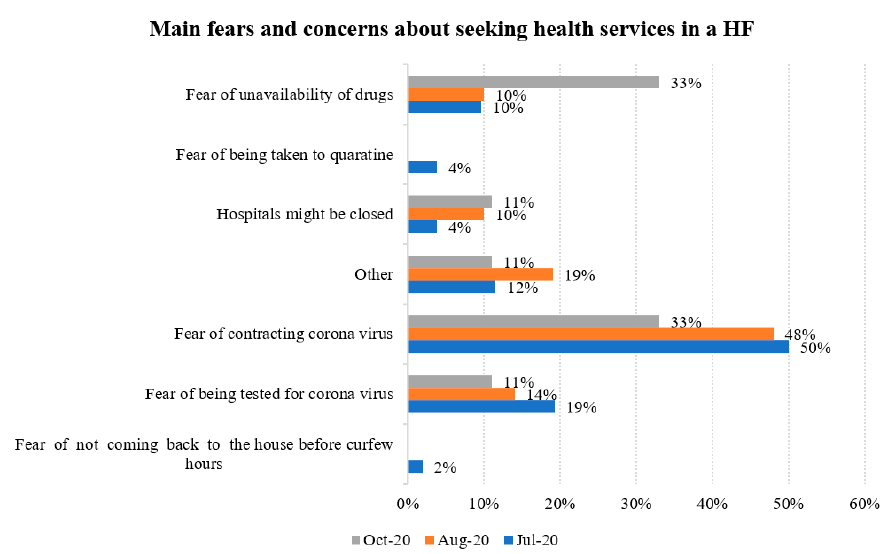
Figure 2. Main fears and concerns about seeking health services in health facilities.